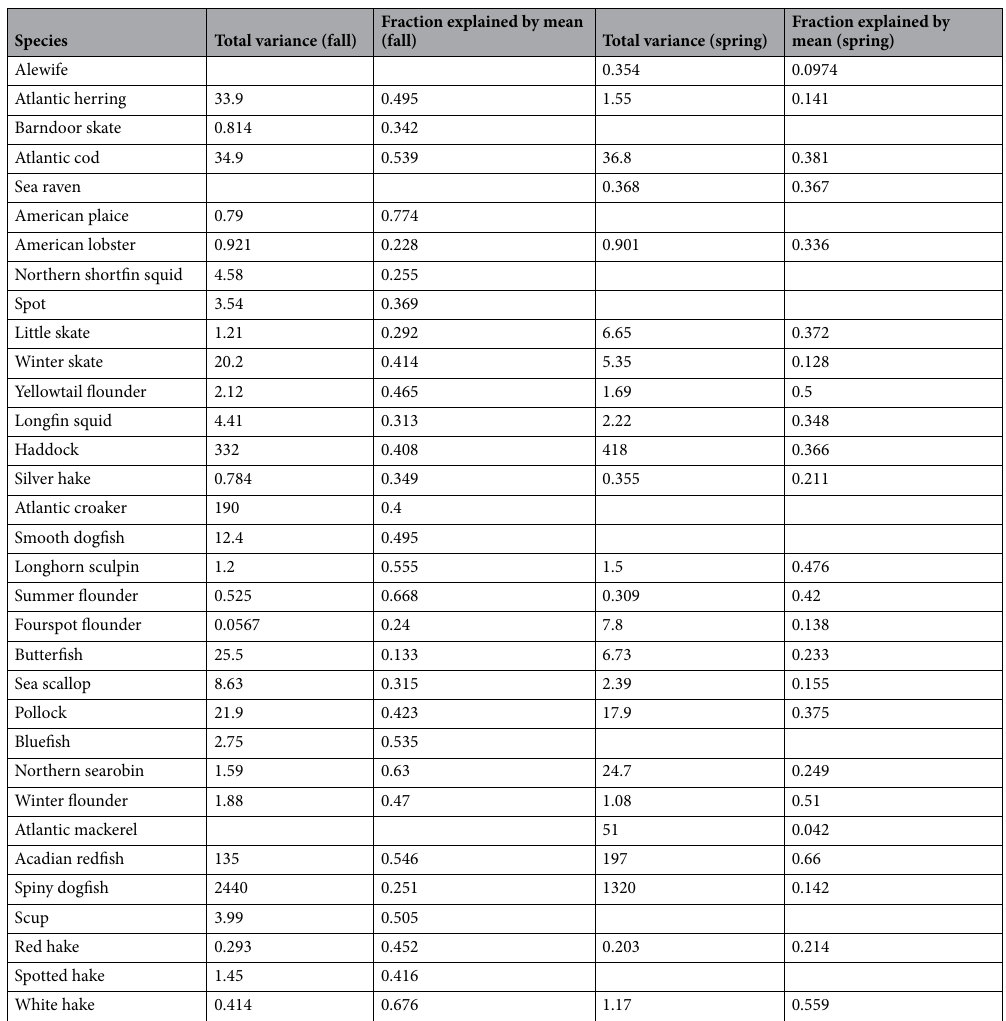
Table 1. Total variance and Fraction of the total variance that comes from the